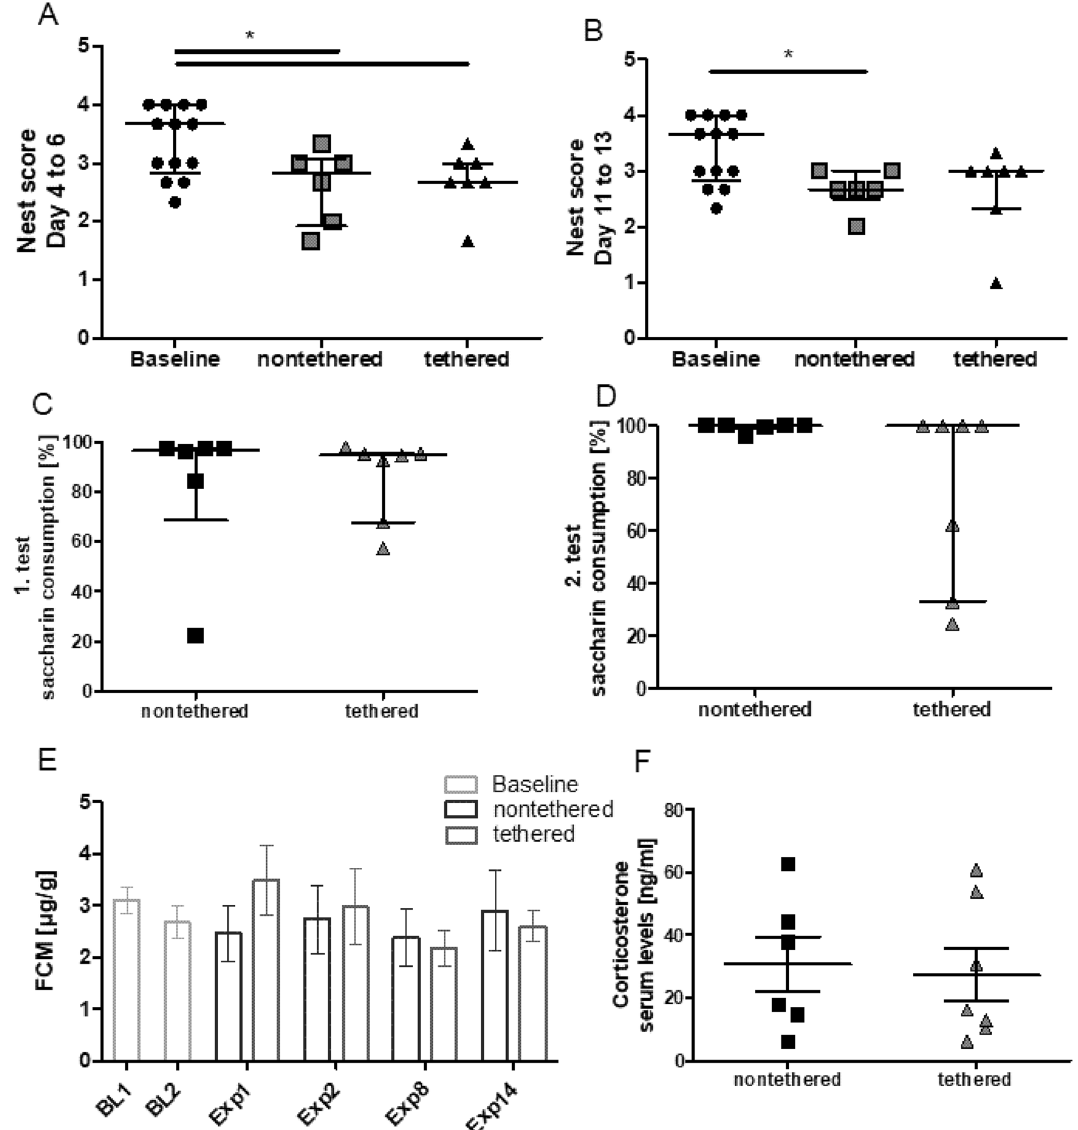
Figure 7. Nest building, anhedonia ‐ associated behavior, fecal corticosterone metabolite (FCM) levels and serum corticosterone levels for the nontethered (n = 6) and tethered (n = 7) animals. Baseline data: n = 13 animals. ( A , B ) Averaged nest building scores for day 4 to 6 ( A ) and day 11 to 13 ( B ). No significant differences between the nontethered and tethered animals were detected. ( C , D ) Anhedonia ‐ associated behavior for the first week ( C ) and the second week ( D ). No significant differences between the nontethered and tethered animals were detected. ( A – D ) Data are presented as median (interquartile range). Differences between the groups were tested using the Mann–Whitney-U test. An asterisk indicates a significant difference. ( E ) Fecal corticosterone metabolite (FCM) levels for Baseline 1 (BL1), Baseline 2 (BL2), Experimental day 1 (Exp1), Experimental day 2 (Exp), Experimental day 8 (Exp8) and Experimental day 14 (Exp14). No significant differences were detected. Data are presented as mean ± SEM. Differences between the groups were tested using a two-way ANOVA with factors “nontethered/tethered” and “days”, followed by a post-hoc Bonferroni multiple comparison test. ( F ) No significant differences between the nontethered and tethered animals were detected for the serum corticosterone levels. Data are presented as mean ± SEM. Differences were tested using an unpaired t-test